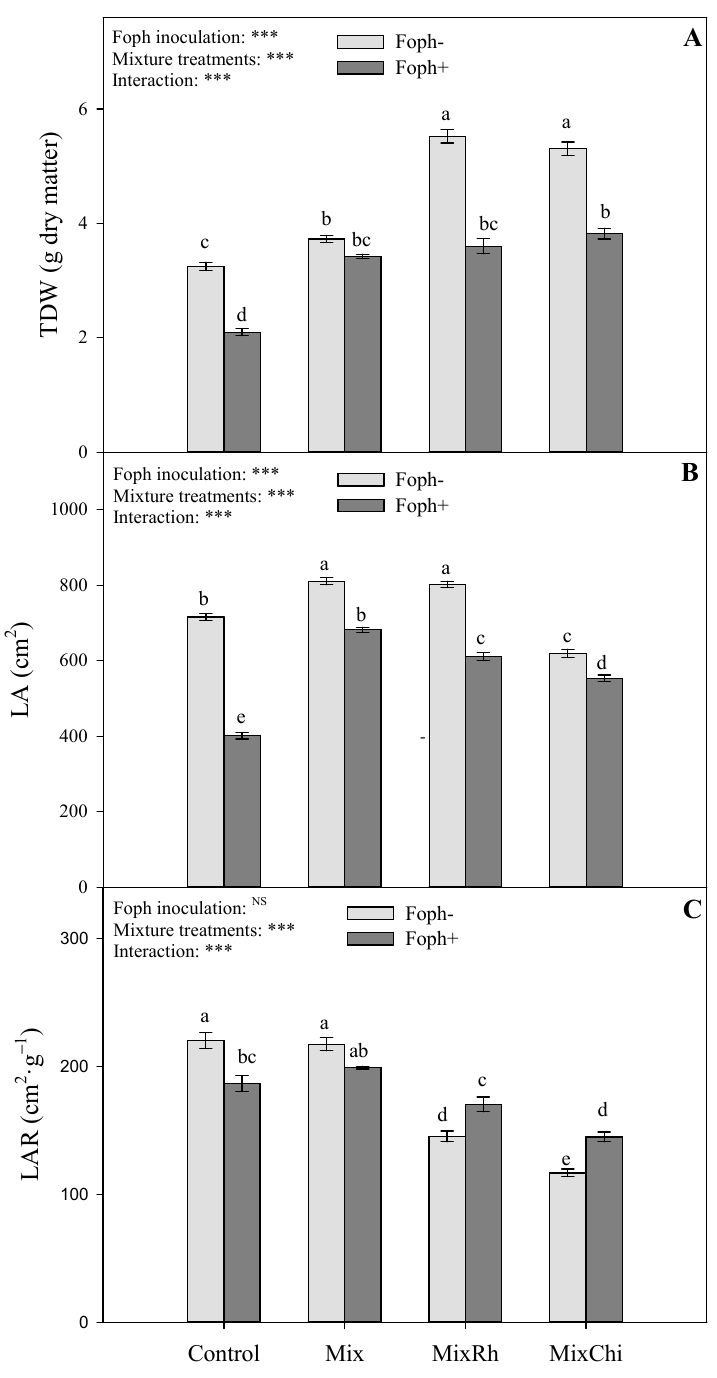
Figure 2. Effect of the application of mixtures of biological control agents and organic additives (Mix ( T. virens + B. velezensis ), MixRh ( T. virens + B. velezensis + burnt rice husk), and MixChi ( T. virens + B. velezensis + chitosan)) on ( A ) total dry weight, ( B ) leaf area, and ( C ) leaf area ratio (LAR) of cape gooseberry plants without (light grey bars) and with (dark grey bars) F. oxysporum f. sp. physali (Foph) inoculation at 50 days after inoculation (DAI). Error bars represent the mean of four values ± standard error. Significant differences between treatments are indicated by different letters according to the Tukey’s test ( p ≤ 0.05). *** p < 0.001values of the ANOVA of Foph inoculation, mixture treatments and their interaction. N.S. Not significant.